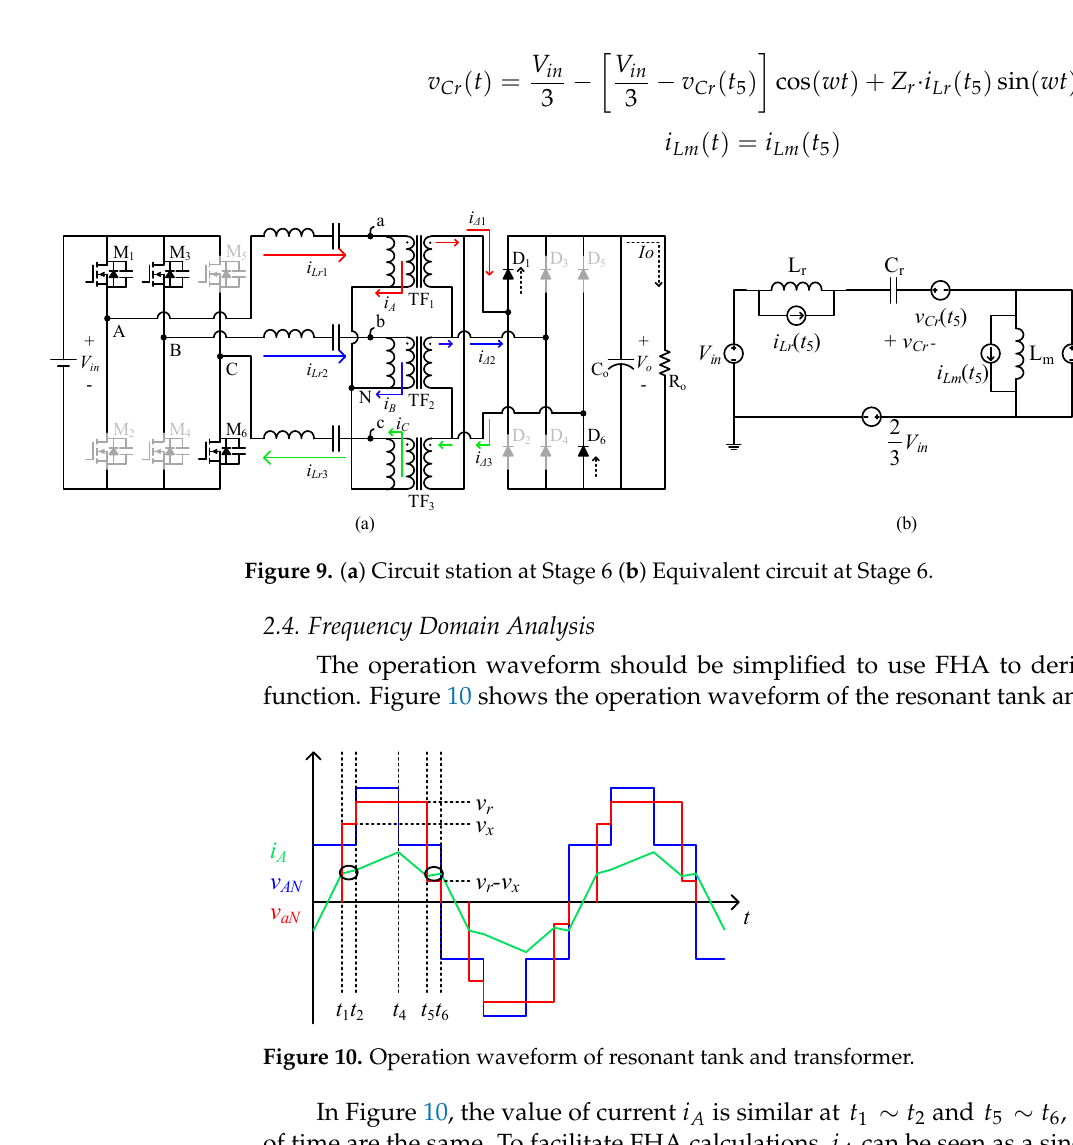
Figure 10. Operation waveform of resonant tank and transformer.